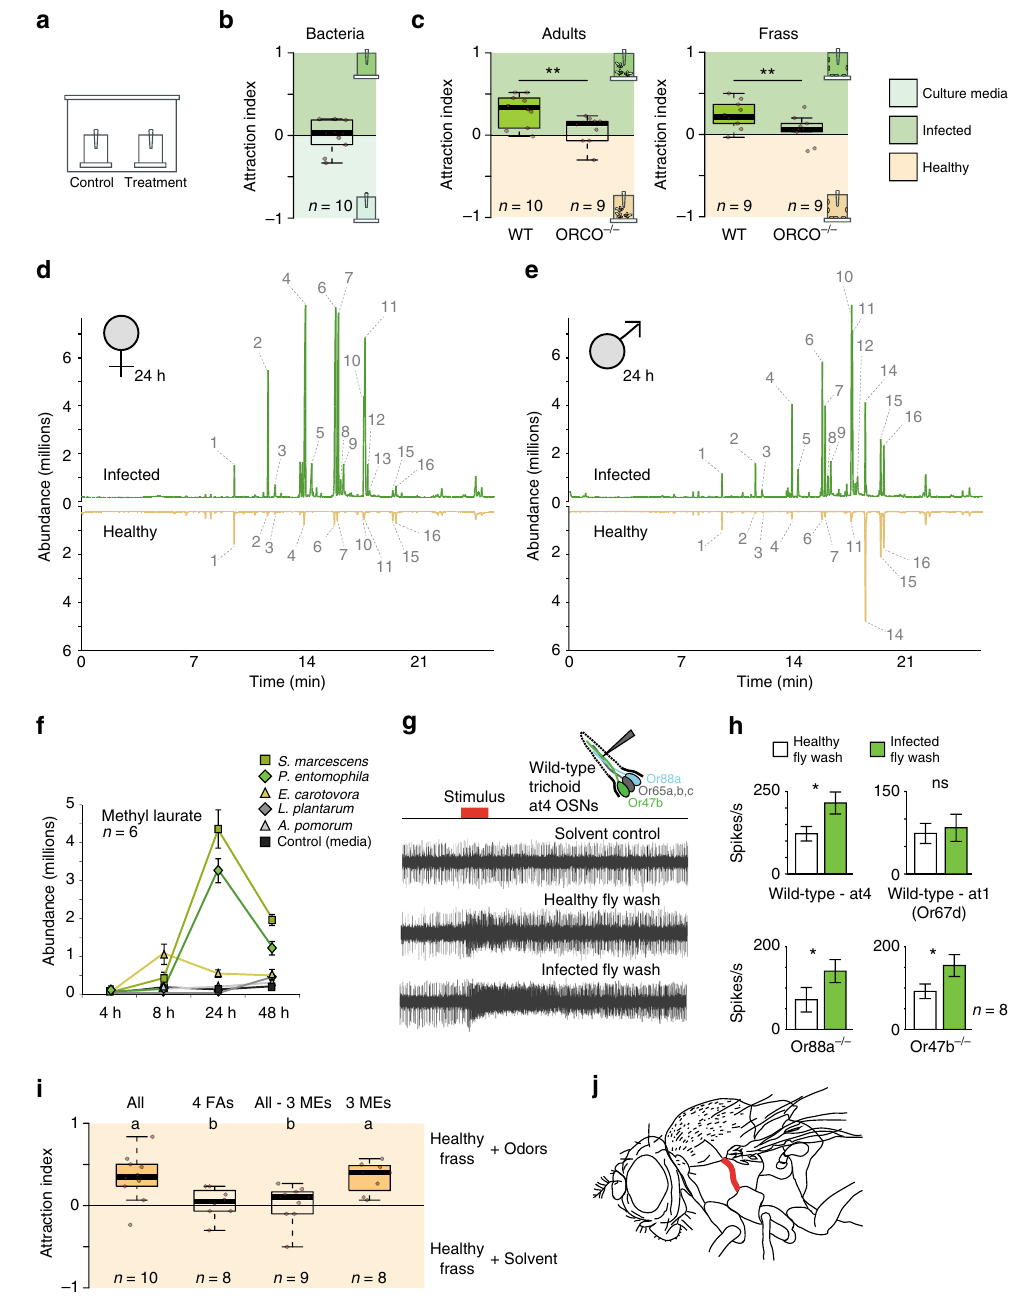
Fig. 1 Effects of infection on Drosophila attraction and odor pro fi le. a Experimental design of attraction assays. b Attraction index of adult Drosophila toward the olfactory cues from Pseudomonas bacteria or from growth media control. c Attraction indices or naive wild type or Orco mutant fl ies given the choice between other adults with and without Pseudomonas infection or between frass of fl ies with or without infection. Attraction index: ((no. of fl ies in treatment trap) − (no. of fl ies in control trap)) / total no. of fl ies. d , e GC-MS pro fi le of female d and male e Drosophila adults either infected with Pseudomonas